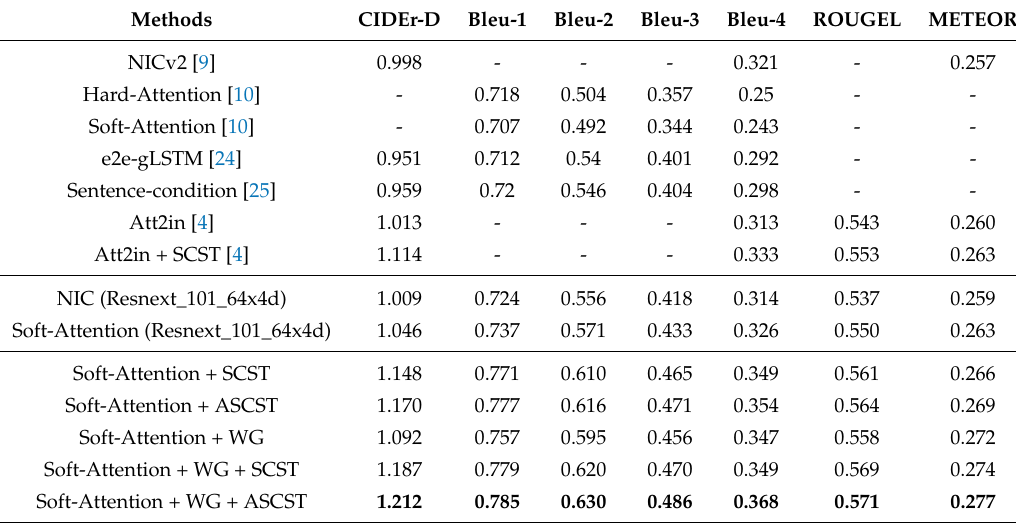
Table 1. Single-model image captioning performance without RL on the MSCOCO Karpathy test split. BLEU-n is a geometric average of precision over 1-to n-grams.NIC: neural image caption.